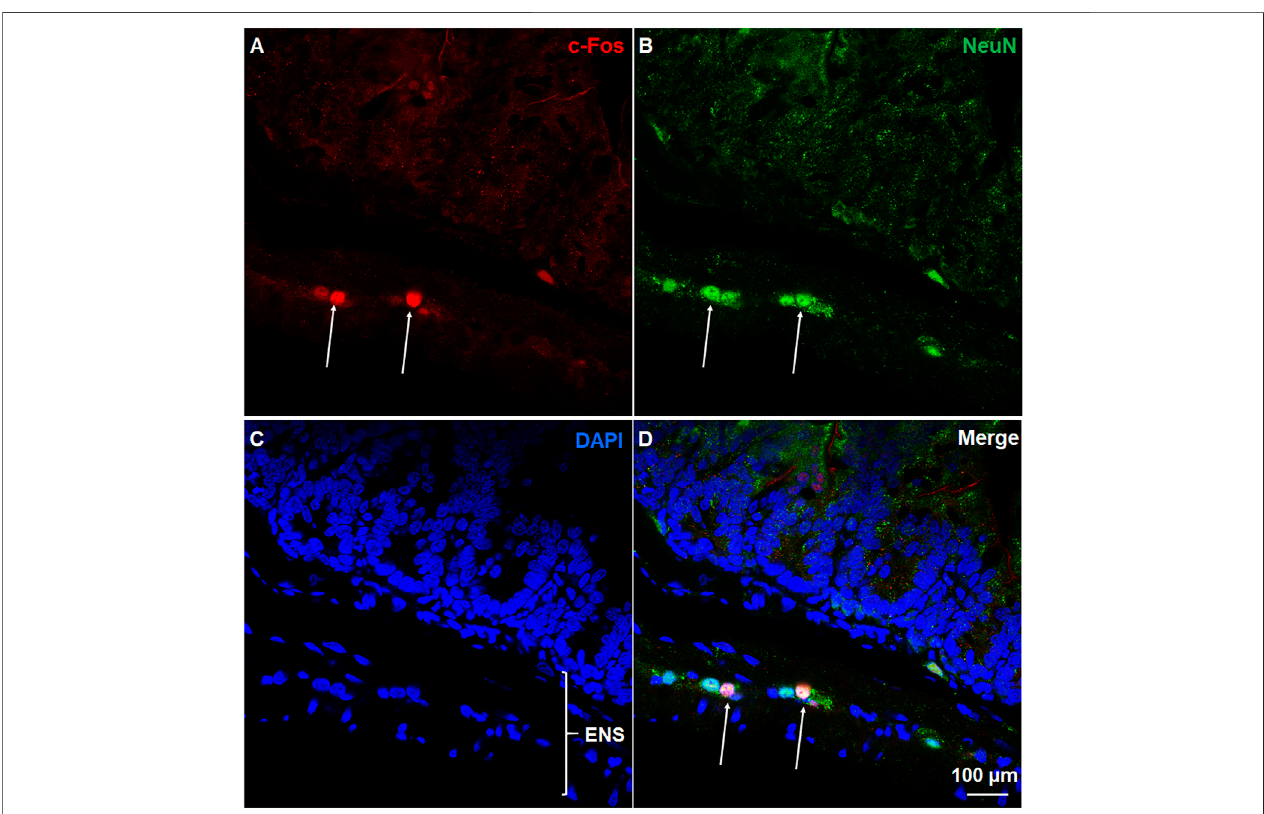
FIGURE 6 | Immunohistochemical analysis of c-Fos expression in NeuN-positive neurons of ENS. Co-staining of jejunum sections from ZD7288 (1 mg/kg, i. p.)- treated shrews with rabbit c-Fos and mouse anti-NeuN antibodies followed by Alexa Fluor 594 donkey anti-rabbit and 488 donkey anti-mouse secondary antibodies. NeuN, a neuronal marker of intrinsic primary afferent neurons of the enteric nervous system. Nuclei were stained with DAPI in blue. (A – D) Representative images (60x) show c-Fos expression seen in neurons of the enteric nervous system (ENS), which is embedded in the lining of the intestine. Scale bar, 100 μ m.